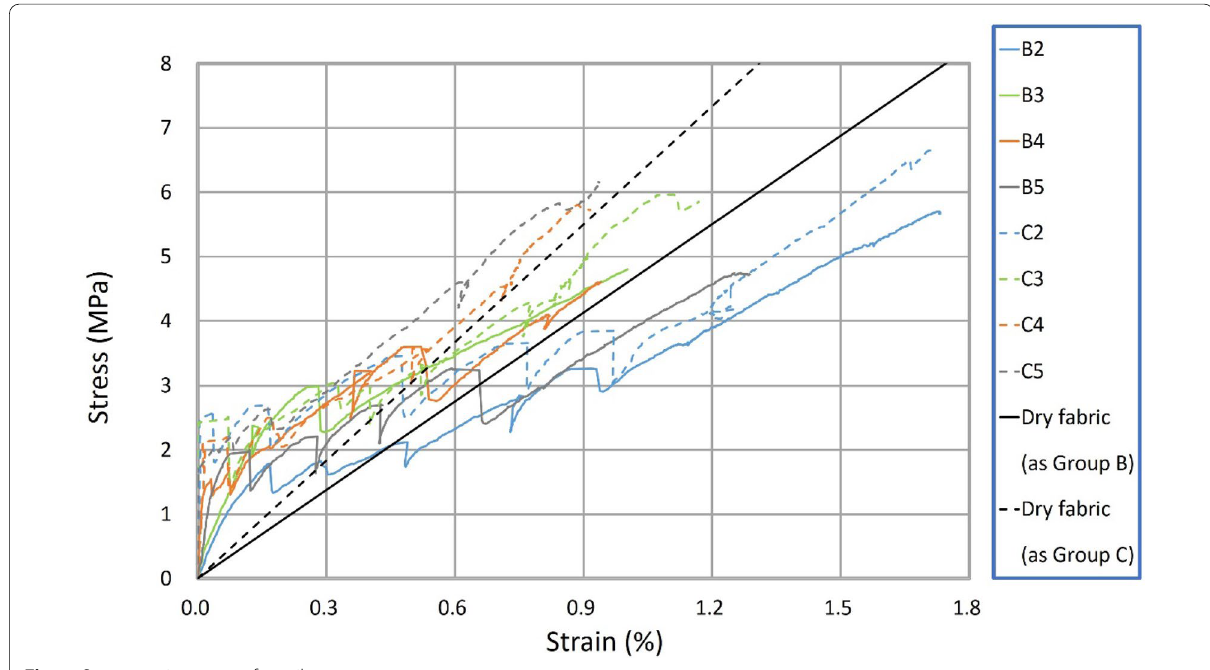
Fig. 7 Stress–strain curves of tensile tests.